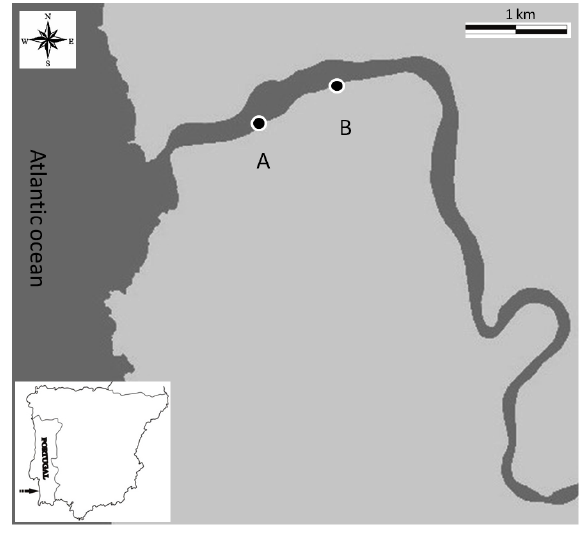
Figure 1. Map of the study area: Mira estuary (Portugal) and sam- pling sites ( A and B